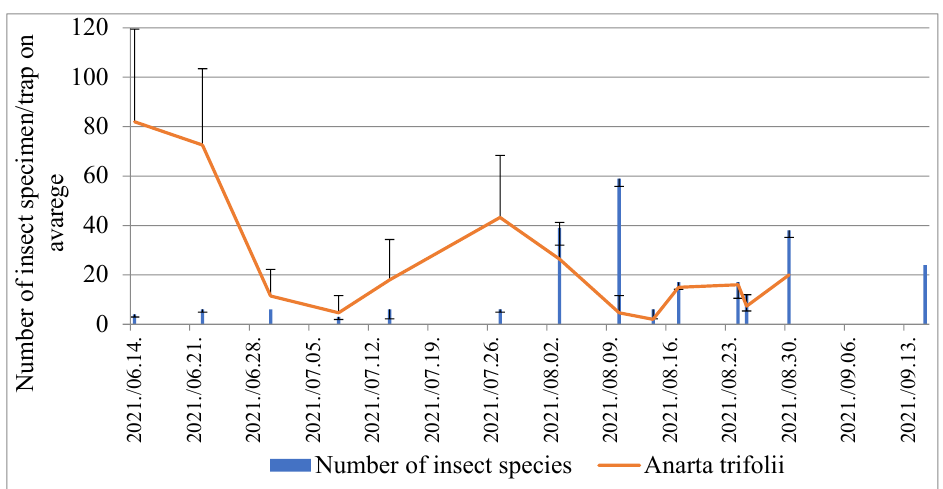
Figure 4. Dynamics of insect attraction to light traps and summer dynamics of the nutmeg moth. Central zone of Krasnodar Krai.